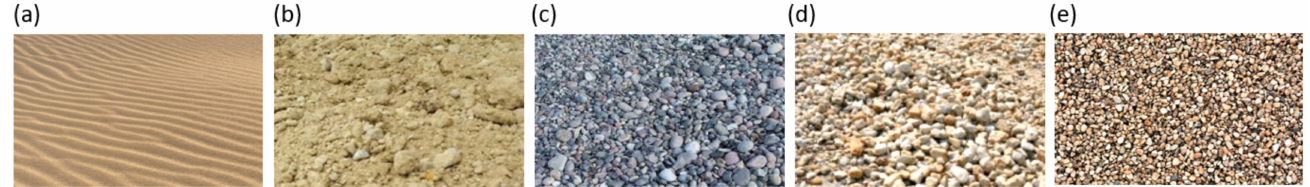
Figure 7. ( a ) Dune sand, ( b ) sand and gravel, ( c ) gravel, ( d ) crushed stone, and ( e ) rubble; the characteristics and spatial-temporal distribution of geomorphic traits are important factors for monitoring